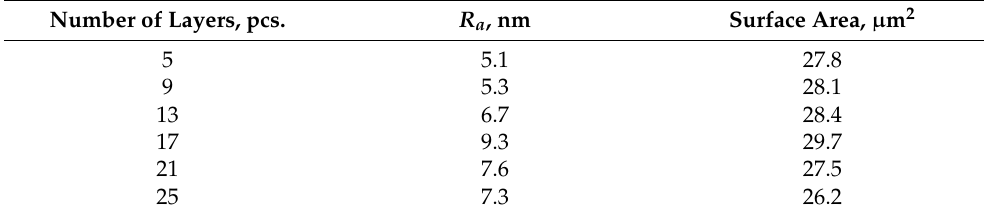
Table 2. Roughness parameters and surface areas of the LB SA films with different numbers of monolayers. Number of Layers, pcs.